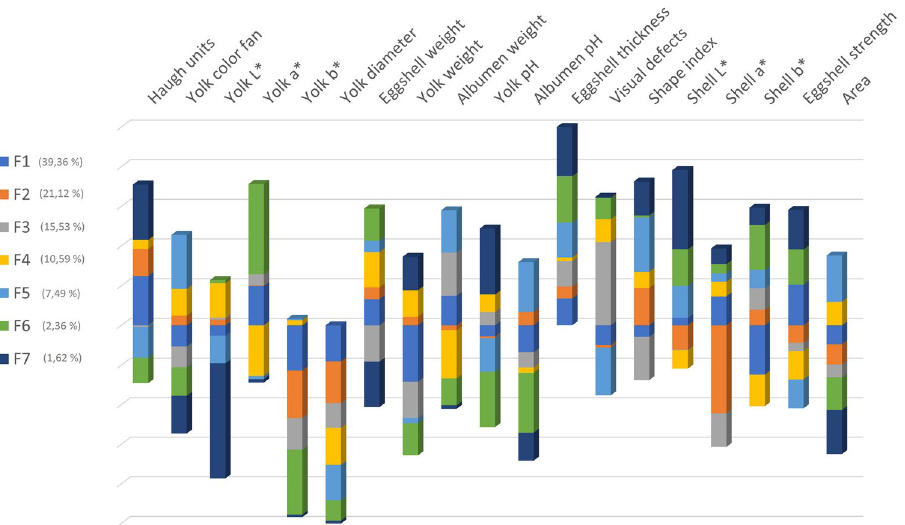
Figure 2. Discriminant loadings for external and internal quality-related traits determining the relative weight of each trait on each canonical discriminant